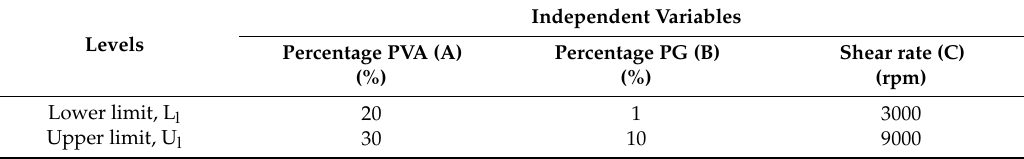
Table 1. Constraints of independent variable